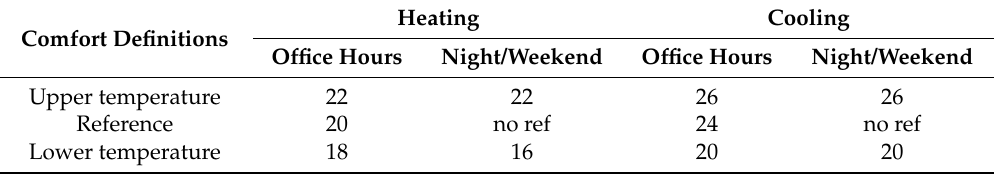
Table 5. Reference values and comfort band limits for temperature (in ◦ C). Office hours are considered from 08:00 to